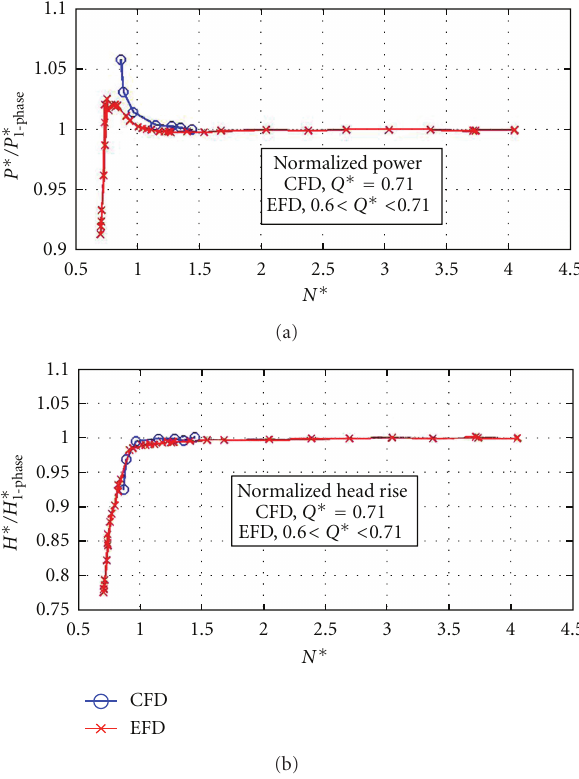
Figure 4: Waterjet pump, AXWJ-2, cavitating-RANS integrated results at constant Q ∗ = 0 . 71 into breakdown presented with EFD of similar conditions ( Q ∗ = 0 . 71 prior to breakdown, Q ∗ drops precipitously in breakdown). N ∗ = ( p 0in − p v ) / (0 . 5 ρ ∞ n 2 D 2 ). Results from 3D multiphase rotor computations with circumferentially averaged inflow and outflow boundary conditions. Body forces derived from 3D stator RANS represent stator forces. Note that the normalization is with respect to the single-phase flow at the corresponding Q ∗ . Q ∗ is constant for the CFD but varies in the experimental